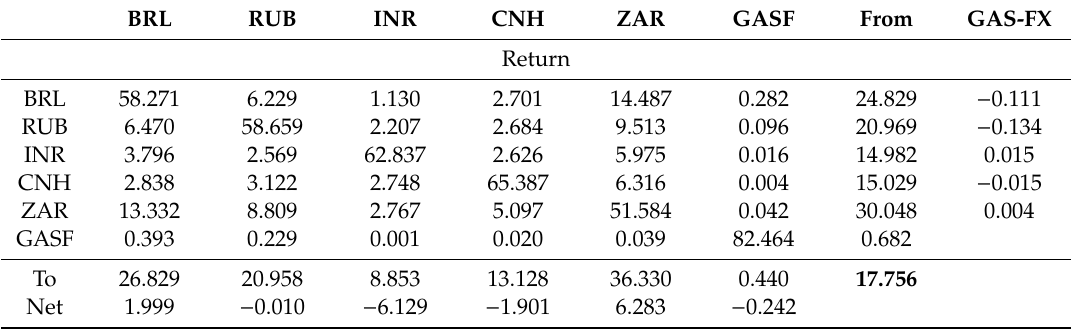
Table 7. Connectedness among the natural gas future price and exchange rates in the frequency domain (short